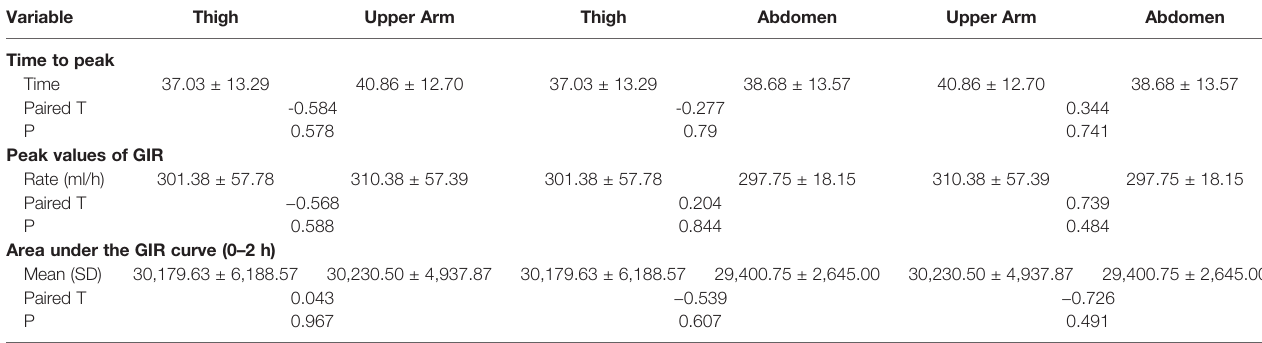
TABLE 3 | The differences in time-to-peak, peak values, and area under the glucose infusion rate curve at different injection sites. Variable Thigh Upper Arm Thigh Abdomen Upper Arm